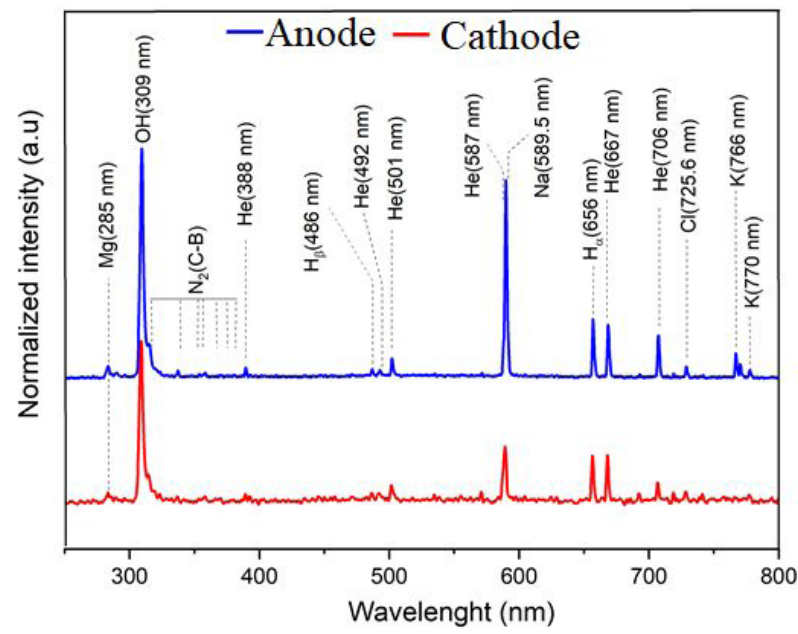
Figure 3. Optical emission spectroscopy (OES) in the wide range of 200 to 800 nm, after 600 s of discharge on HSW solution surface for anodic or cathodic